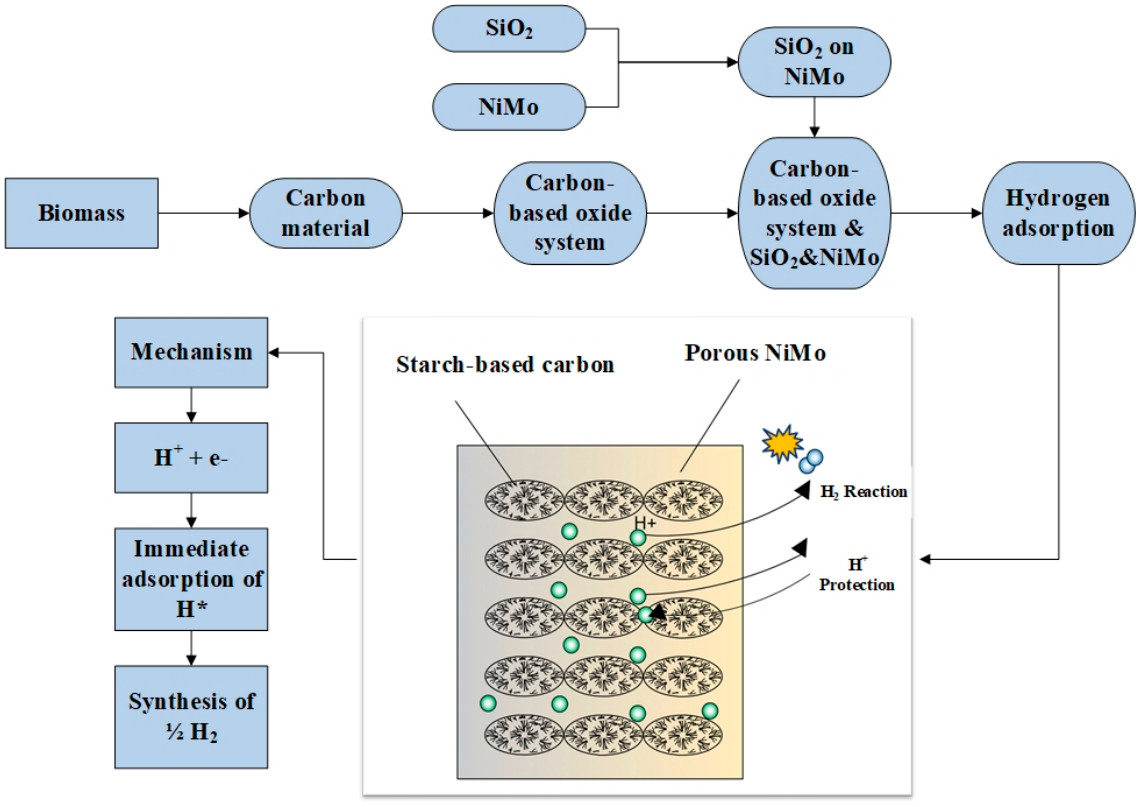
Figure 4. Diagram of the process of obtaining hydrogen by capturing hydrogen on the surface of carbon.